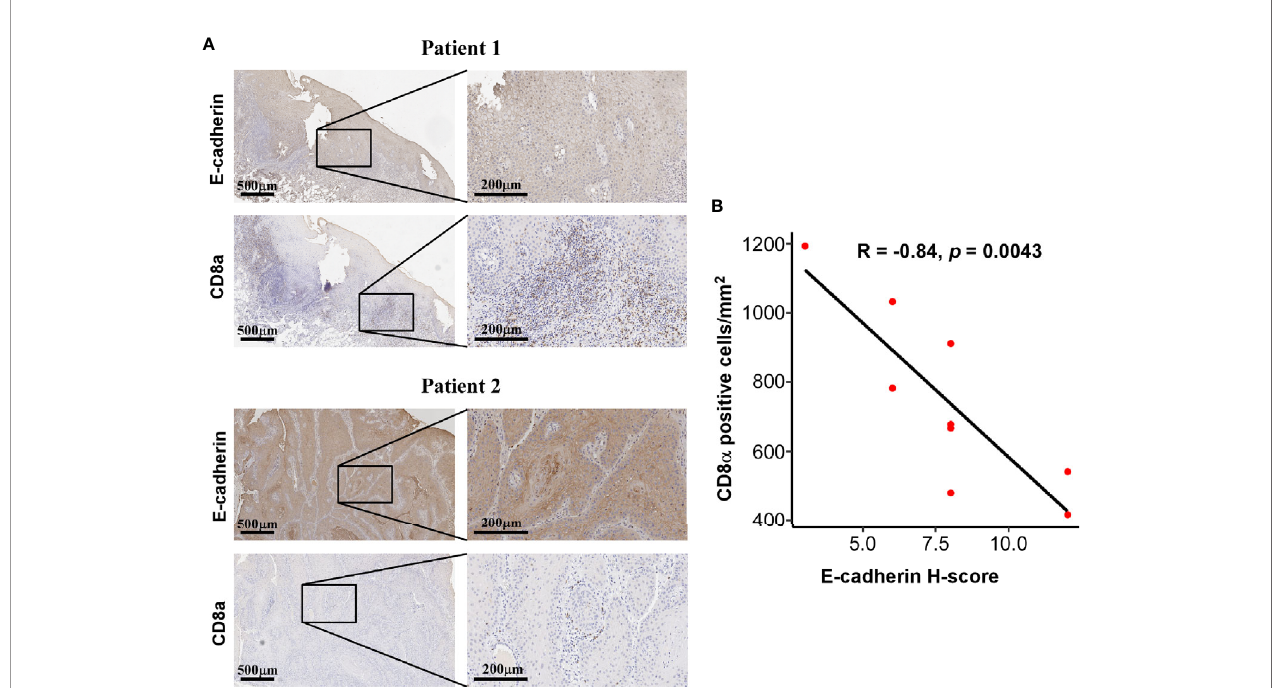
FIGURE 4 | Expression of E-cadherin and CD8a was negatively correlated. (A) Representative IHC images showing a negatively correlated expression pattern of E- cadherin and CD8a in OSCC tissue. IHC images were photographed at 50 × and 200 × magni fi cation. Brown represents positive E-cadherin or CD8a staining, respectively, while blue represents the nucleus. (B) The correlations of CD8a positive cells per mm 2 and E-cadherin H-score in OSCC tissues. The R and p values were calculated using Spearman correlation coef fi